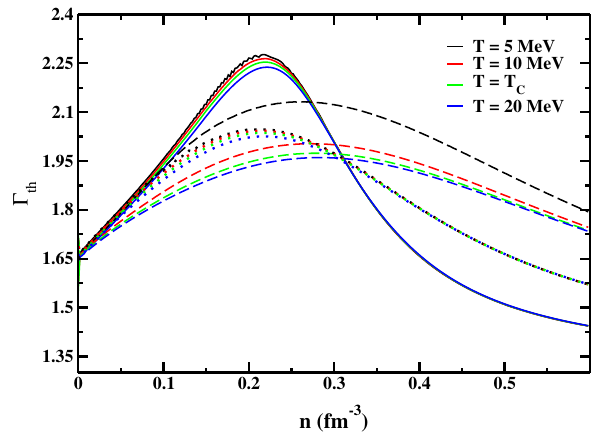
Fig. 7 Variation of Curvature parameter and Skewness parameter at saturation density ( K sym , 0 and Q sym , 0 respectively) with temperature for SNM